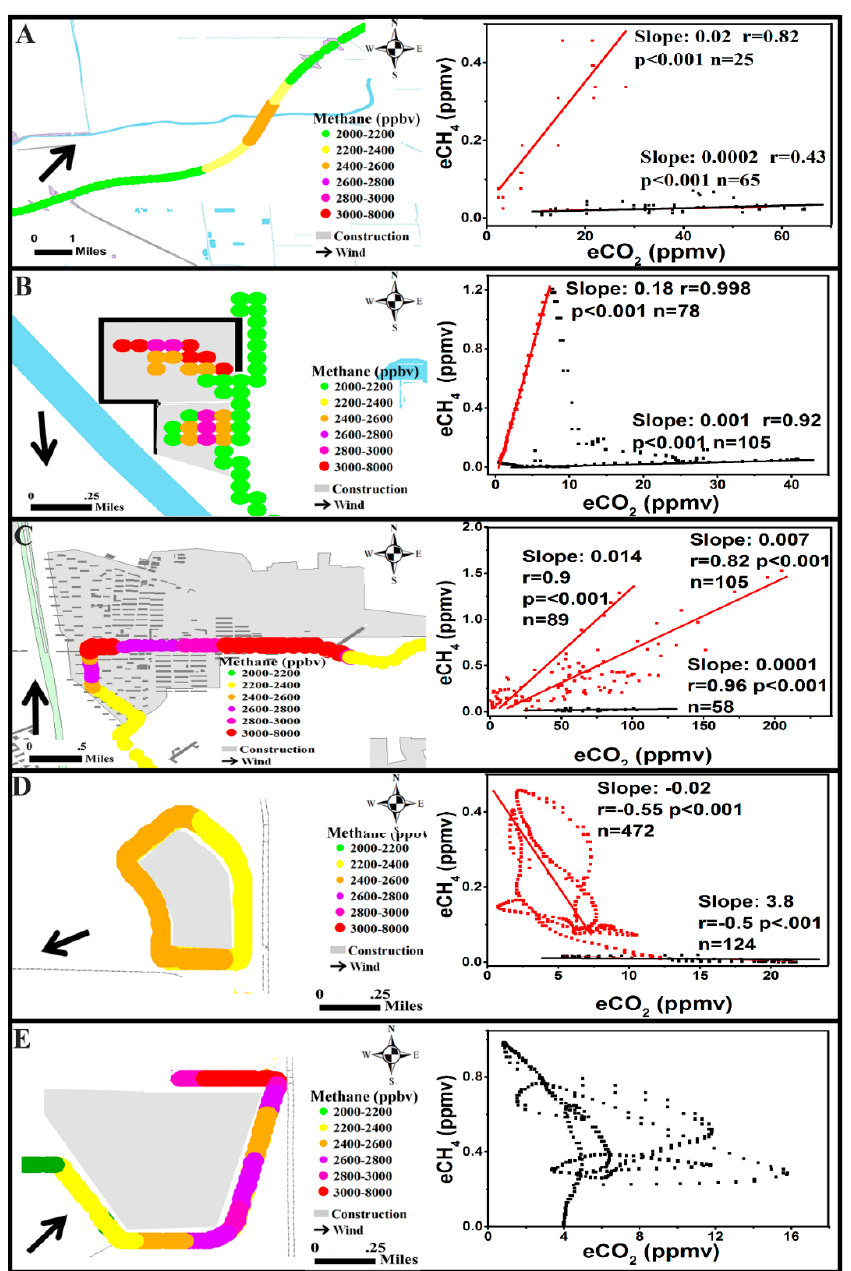
Figure 2. CH 4 concentration map and ratio “fingerprints” (CH 4 :CO 2 ) of five point sources as a function of location: ( A ) an liquified natural gas (LNG) carrier; ( B ) an LNG filling station; ( C ) a residential area; ( D ) an LNG power station; ( E ) a refuse landfill. In A–D, the red dots represent the measurements of which high levels of CH 4 were associated with low CO 2 concentrations and black dots represent that the measurements where high CO 2 concentrations were associated with low CH 4 concentrations. The red and black lines are the linear regression results corresponding to the two groups of dots, respectively. The linear regressions are as the basis of ordinary least squares.